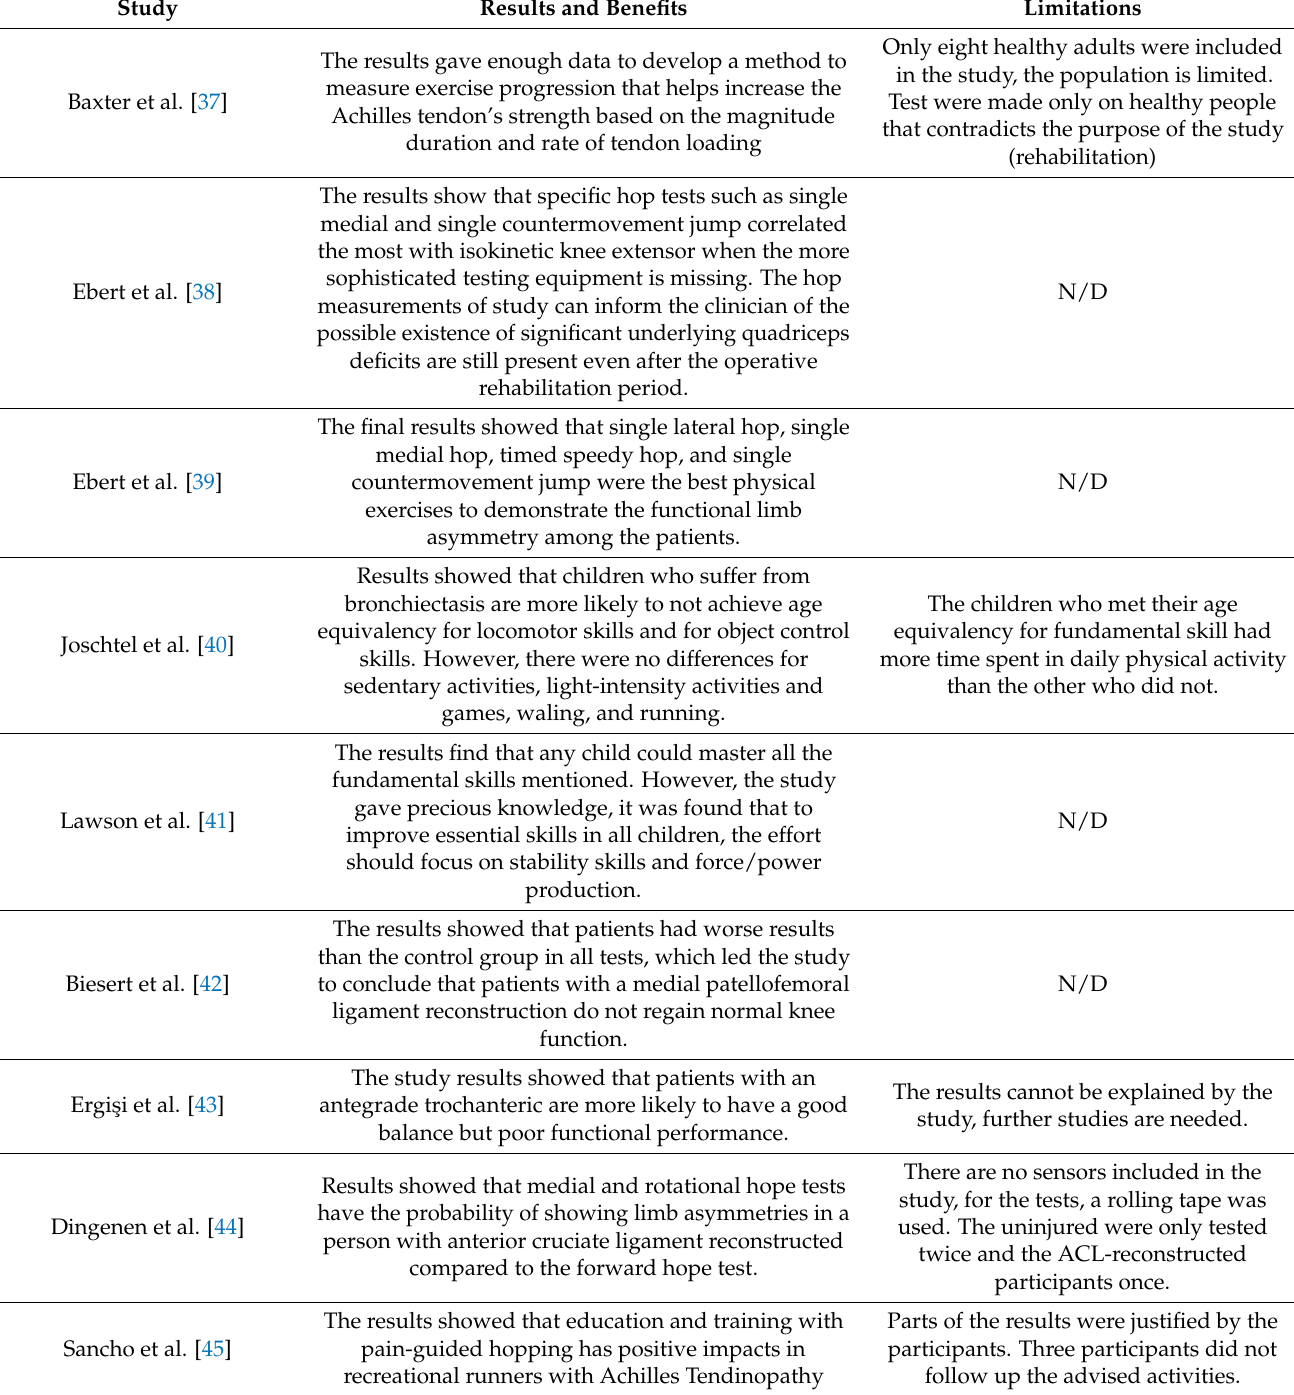
Table 2. Study results and